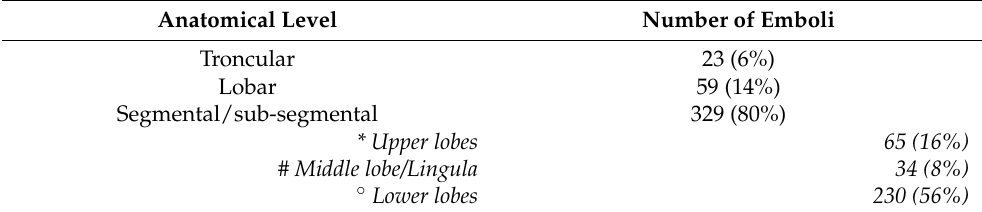
* Upper lobes included three segments: apical, posterior, and anterior on the right side; apico-posterior (counted Table 2. Anatomical distribution of pulmonary emboli (n = 329) in upper, middle, and lower as two segments) and anterior on the left side. # The middle lobe/lingula included two segments: medial middle pulmonary segments (20 segments in 61 patients). lobe and lateral middle lobe on the right side; superior lingular and inferior lingular on the left side. ◦ Lower lobes included five segments: superior, medial, anterior, lateral, and posterior on the right side; superior, anteromedial (counted as two segments), lateral, and posterior on the left